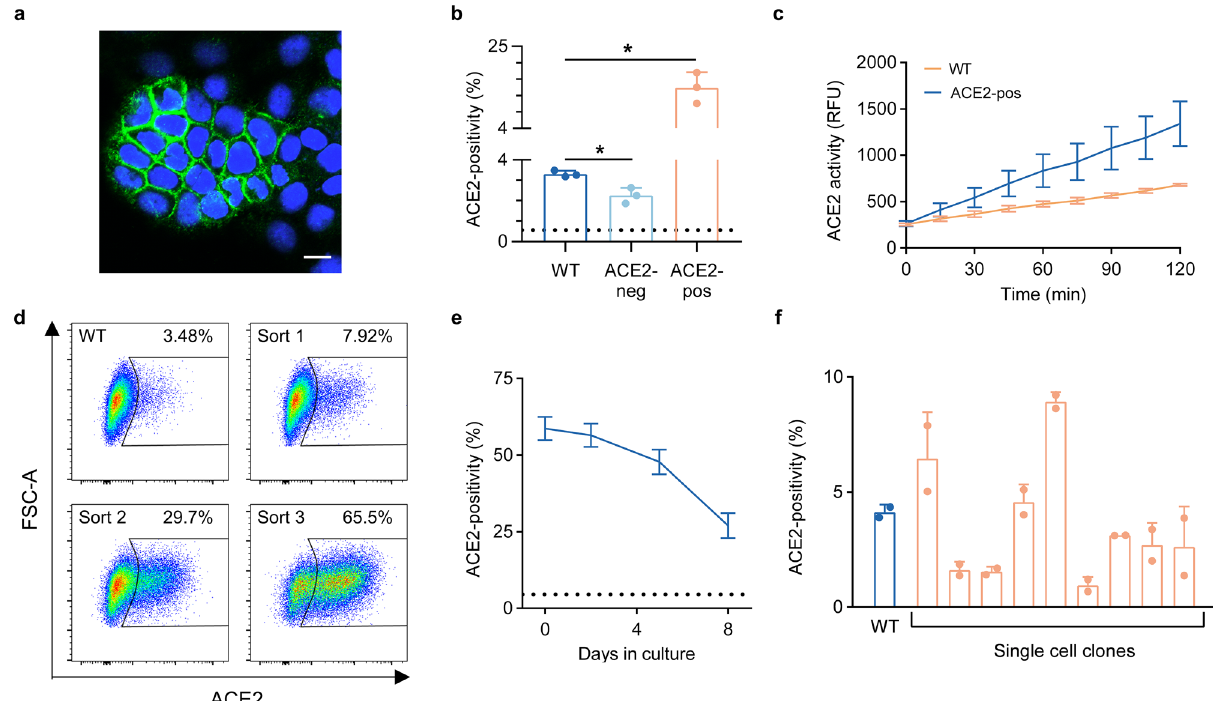
Figure 4. Heritability of ACE2 expression in HuH7 cells. ( a ) Immunofluorescence confocal microscopy showing a cluster of ACE2-positive HuH7 cells with endogenous ACE2 (green) and Hoechst nuclear staining (blue). Scale bar = 10 µm. ( b ) ACE2-positivity by flow cytometry in starting wild-type HuH7 cells and after ~ 7 doublings in culture following FACS isolation and expansion of ACE2-positive and ACE2-negative subpopulations. Dashed line represents background signal from cells stained with only secondary antibody. ( c ) ACE2 enzymatic activity over 2 h in wild-type and FACS-sorted ACE2-positive HuH7 cells. ( d ) Flow cytometry plots of ACE2-positivity in HuH7 cells serially enriched for ACE2 abundance over three FACS sorts. ( e ) Decay of ACE2-positivity at various time points of passaging after FACS enrichment of ACE2 abundance. Dashed line represents ACE2-positivity in wild-type HuH7 cells. ( f ) ACE2-positivity by flow cytometry in single-cell HuH7 clones compared to parental cells. Asterisk indicates p < 0.05 by two-tailed Student’s t test. Error